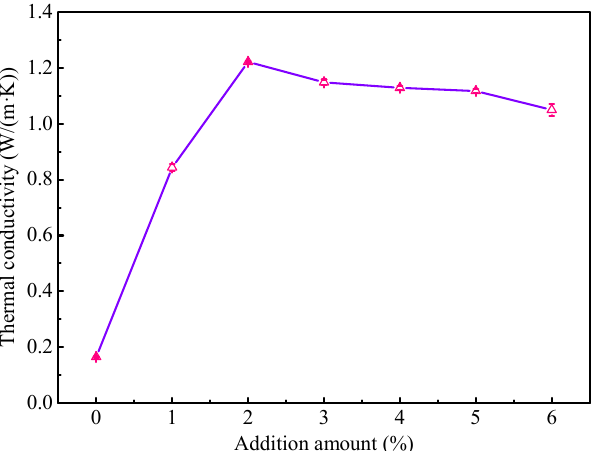
Figure 2. The thermal conductivity results of waterborne polyurethane coating.